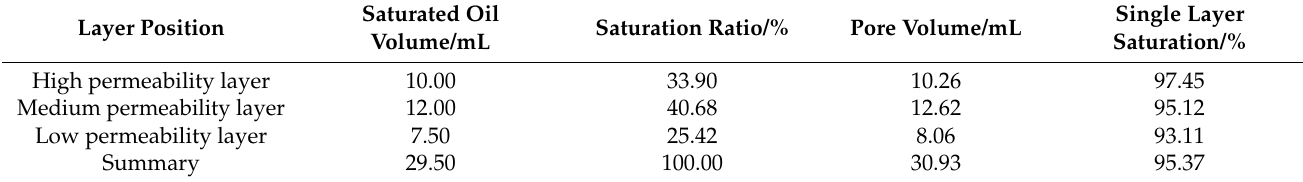
Figure 5. Relation between the rising height of liquid level and the amount of injected oil in the process of oil saturation.